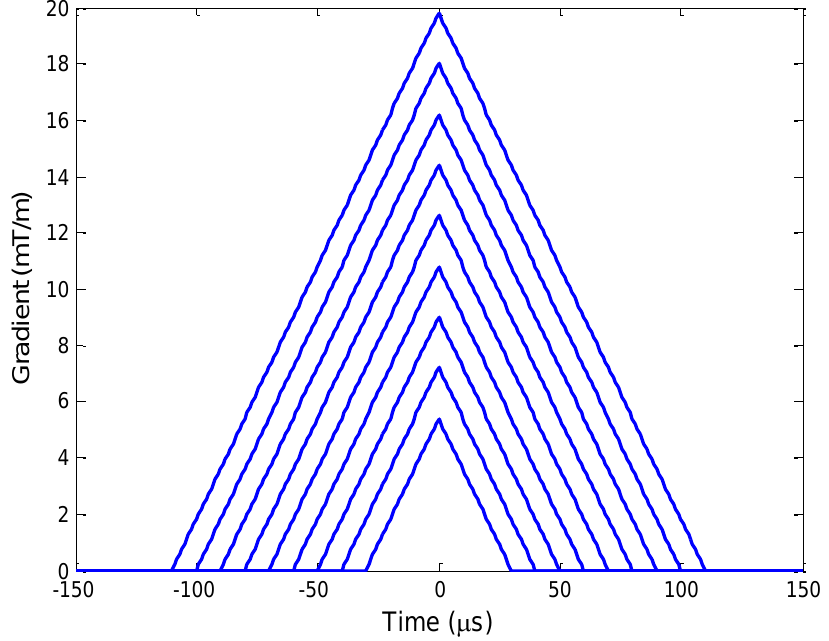
Figure 6. The series of triangular gradient waveforms use for the GIRF calculations. The rise and fall times varied from 30 μs to 110 μs in increments of 10 μs, and all waveforms used a slew rate of 180